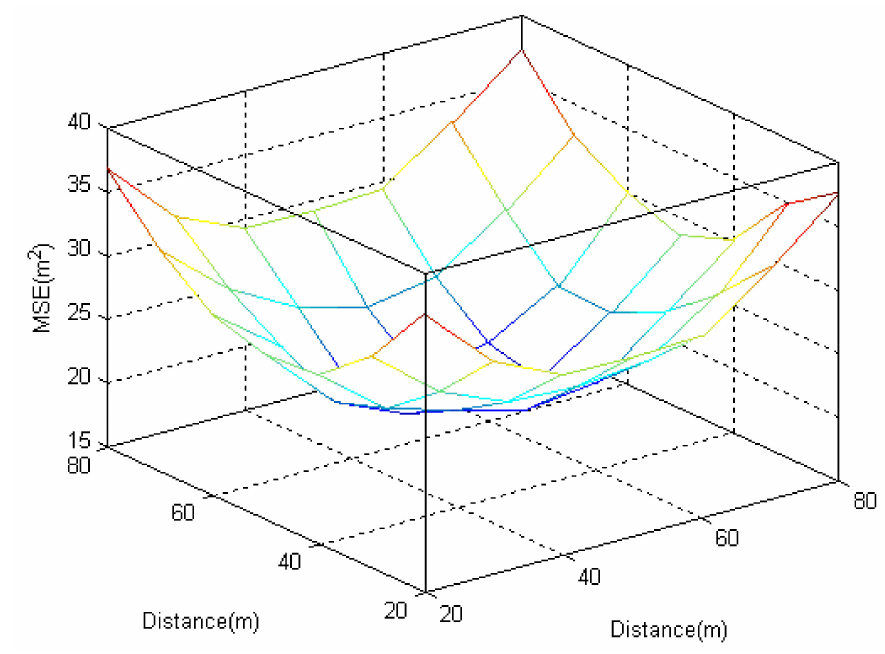
Figure 18. Five reference nodes to estimate the small